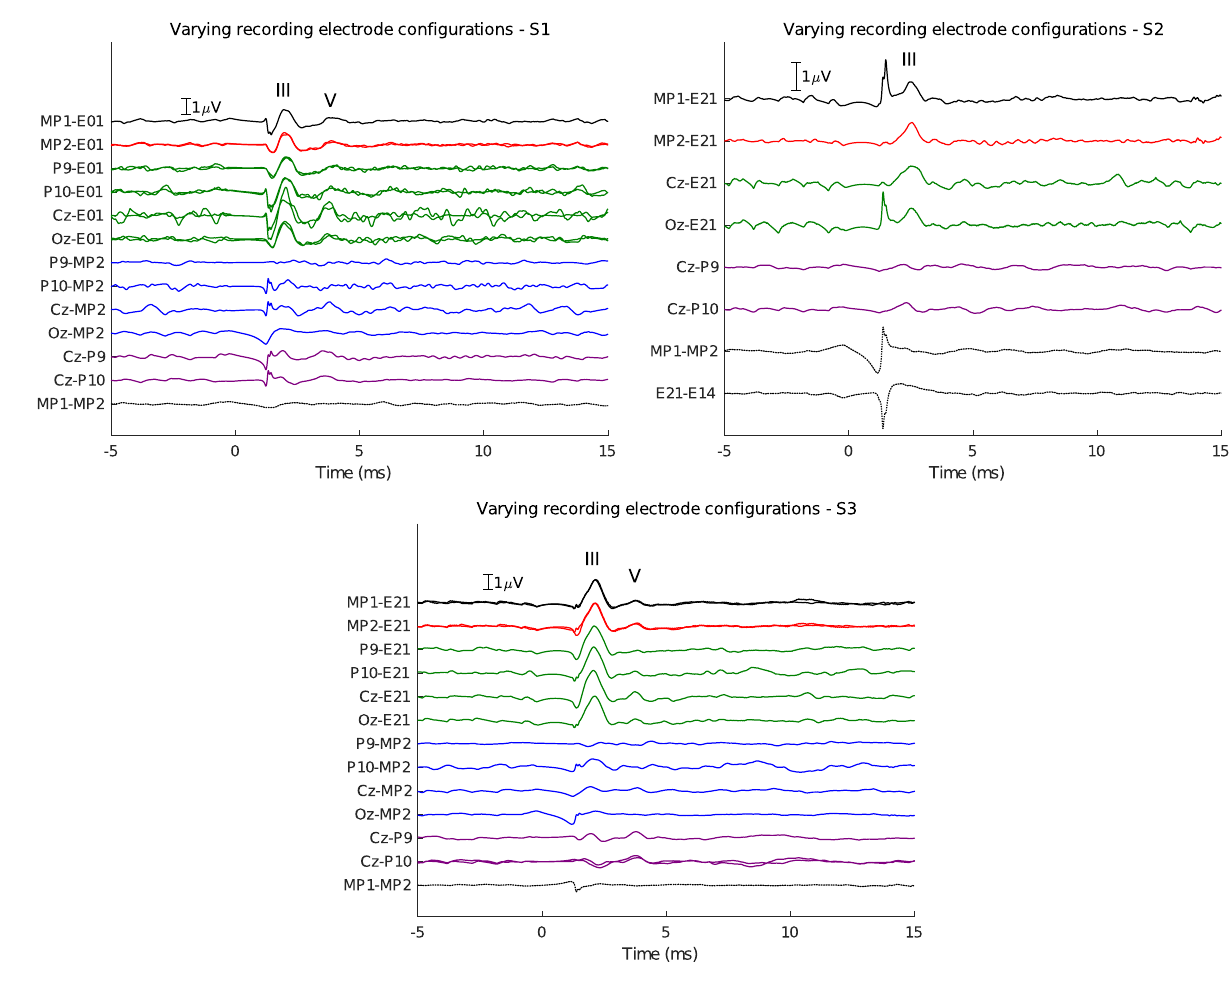
Figure 3. EABRs recorded using various electrode configurations, indicated on the vertical axis and color- coded according to Fig. 1. Waves III and V are marked on the traces. Repeated tests with the same recording electrode configuration are overlaid. Electrical stimulation through the CI was bipolar using electrodes E21-E13 for S1 and E04-E12 for S2 and